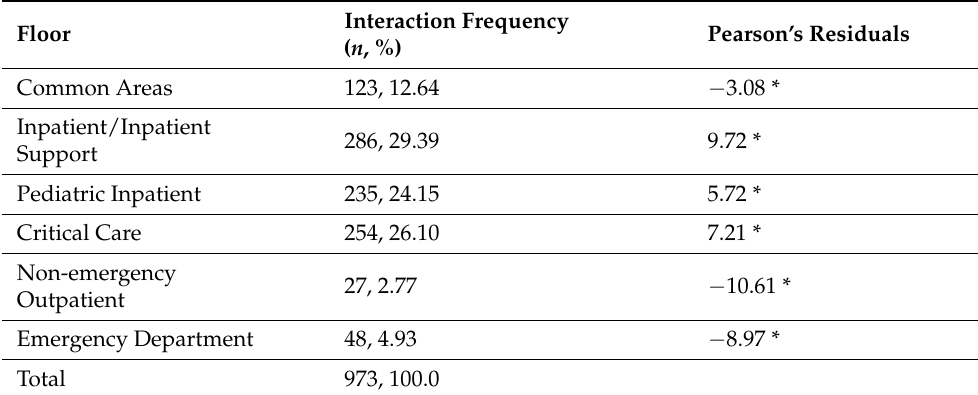
Table 4. Frequency of interactions by hospital